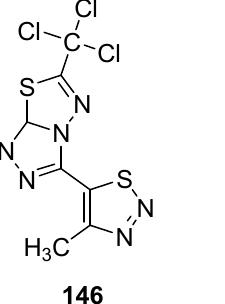
Figure 31. Antifungal benzo[1,2,3]thiadiazole-7-carboxylate derivative 148 .